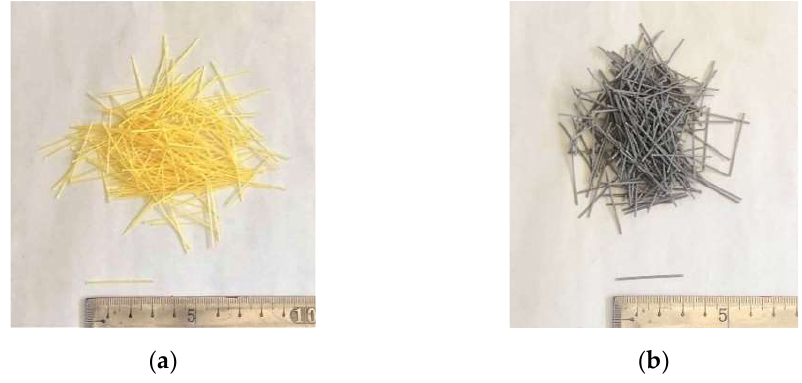
Figure 3. Fibers used for material tests: ( a ) PVA fibers; ( b ) PP fibers.